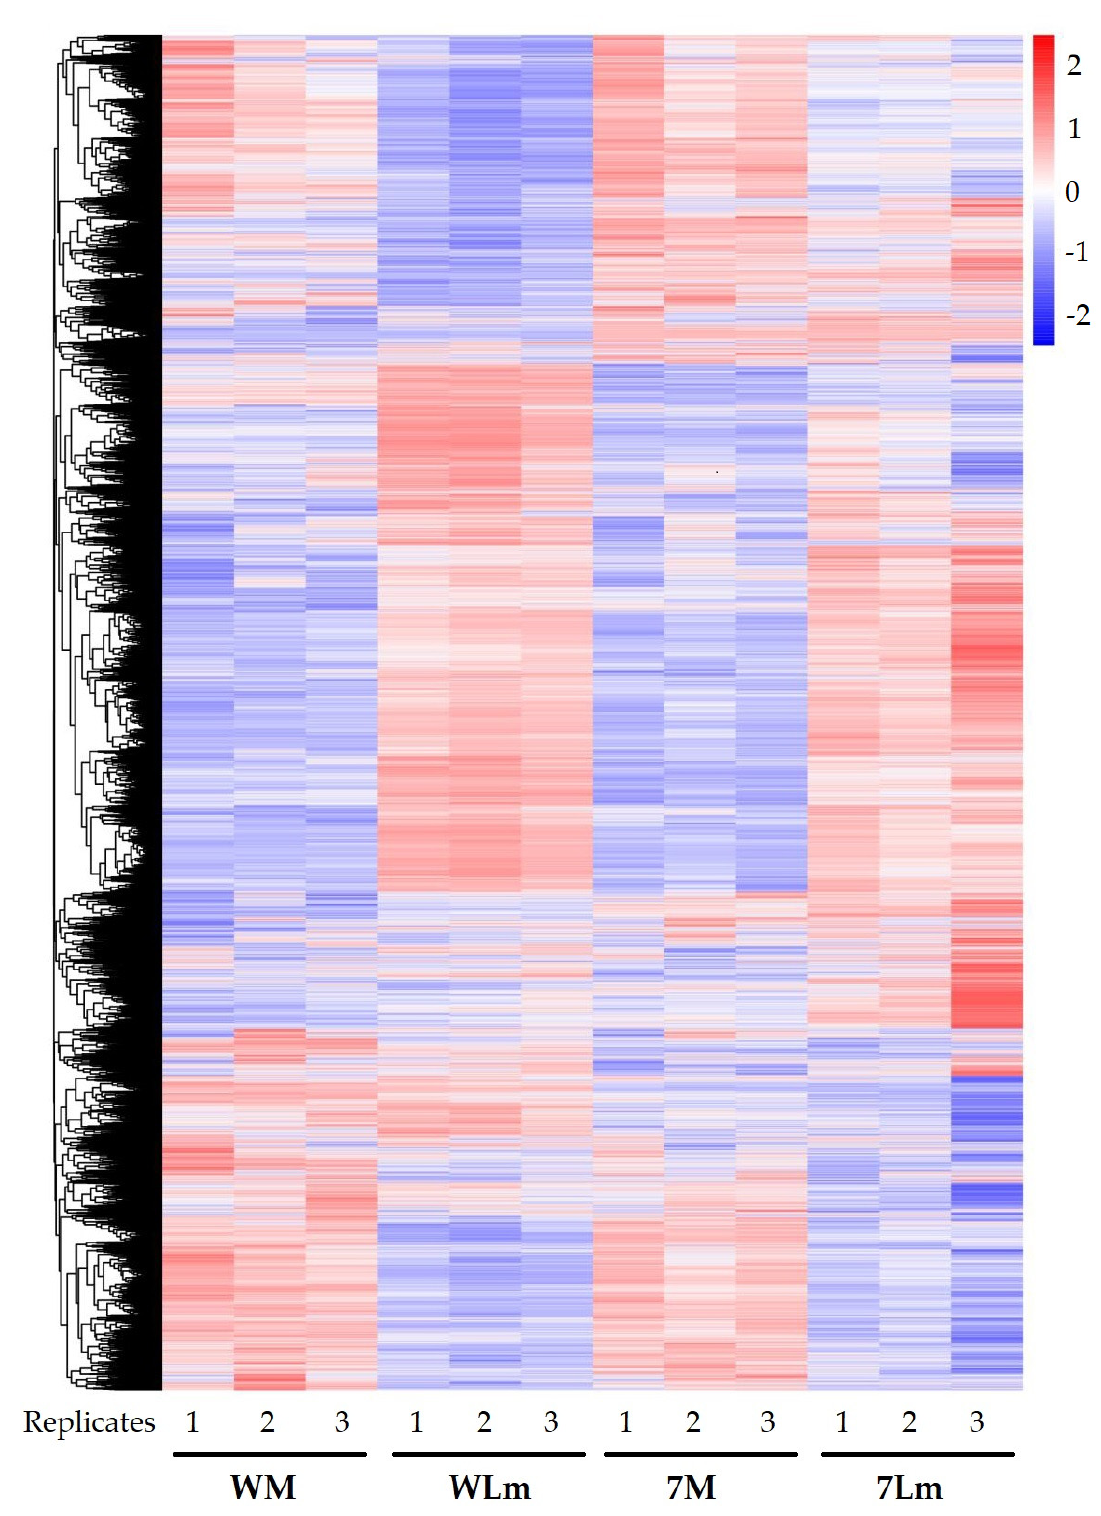
Figure 3. Cluster heatmap of the expressed genes across all samples. Z-score transformation was performed for each gene. Genes with similar expression pattern were clustered together. Relative expressions were scaled from red (high expression) to blue (low expression). Each column represents a sample (replicate), and each row represents a gene. WM: Westar mock, WLm: Westar Lm, 7M: 74-44 BL mock and 7Lm: 74-44 BL Lm.